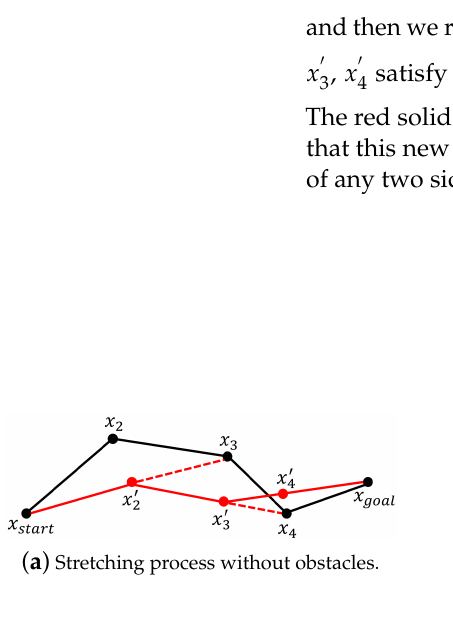
Figure 3. The process of stretching method in different situation.